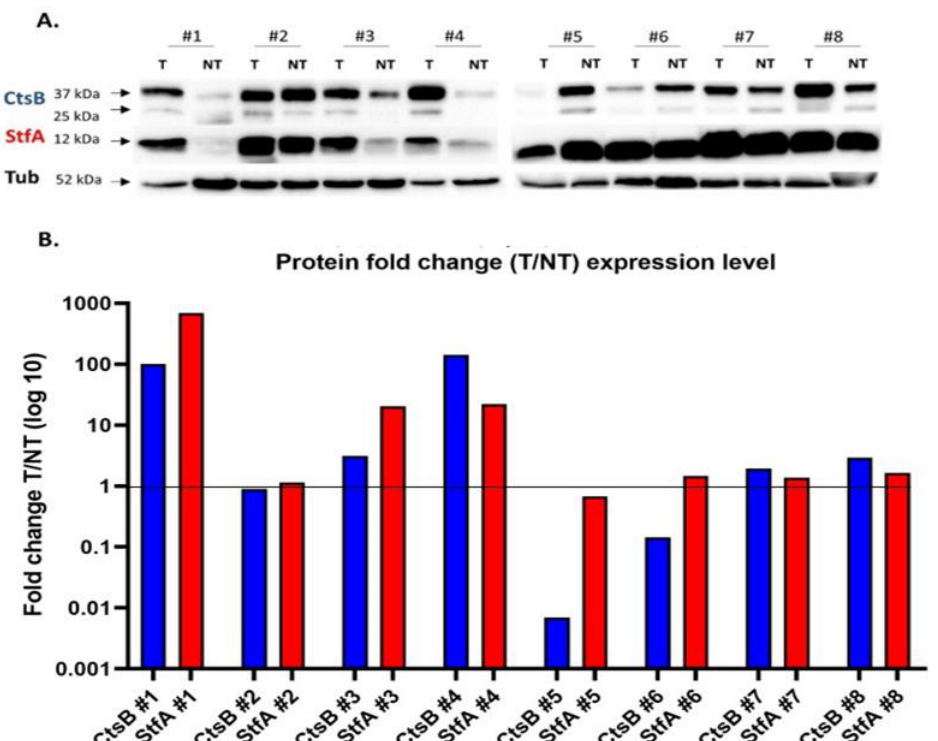
Figure 3. CtsB and StfA protein expression in renal cell carcinoma and adjacent healthy tissues. ( A ) CtsB and StfA protein expression was analyzed in the tissues by western blot. ( B ) Summary of the semiquantitative analysis of the band intensity normalized against tubulin (Tub). The figure represents the ratio between cancer tissue (T) and not tumor (NT) of CtsB or StfA in 8 pairs of tissues randomly selected in our sample collection.